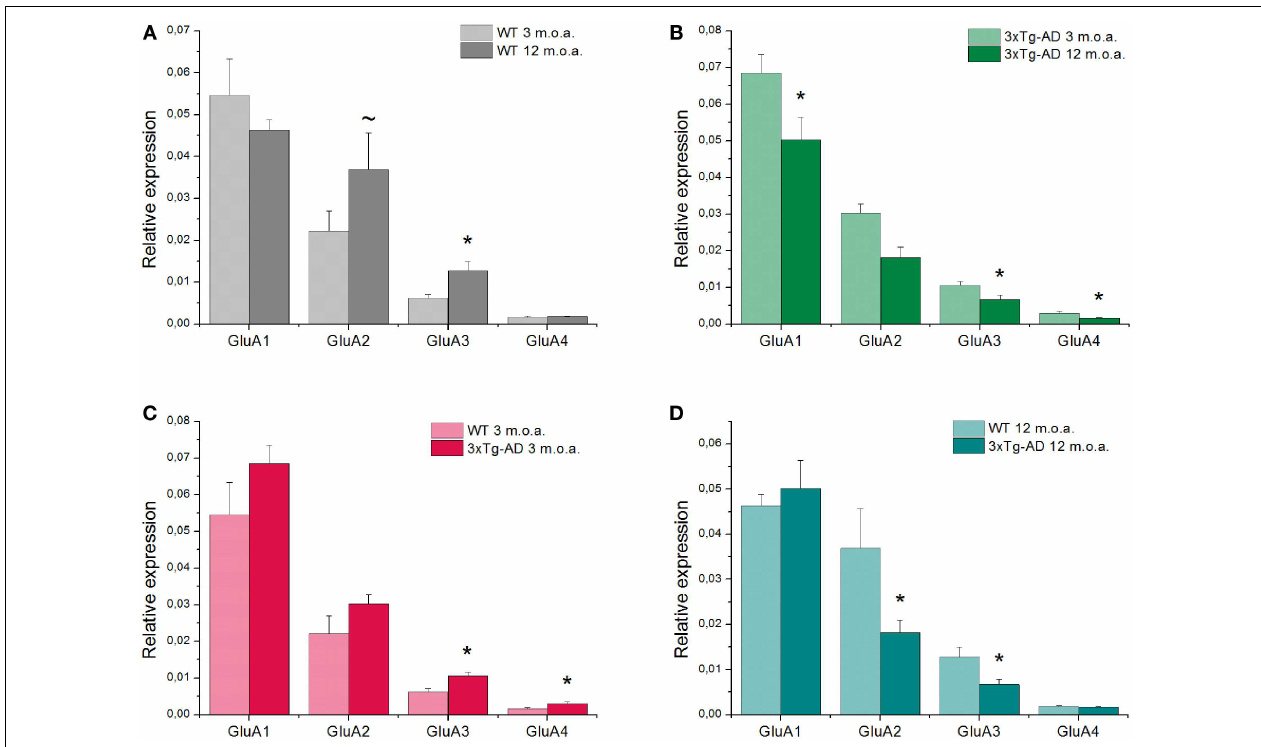
3xTg-AD mice vs.WT mice at 3 m.o.a. showed increases in GluA3 (* p = 0.039) and GluA4 (* p = 0.030) expression levels. (D) Comparison between 3xTg-AD mice vs. age-matchedWT mice showed a decrease in GluA2 (* p = 0.038) and GluA3 (* p = 0.005) expression levels in the 3xTg-AD animals. Data are expressed as mean values ± SEM obtained from six mice in each study group. P value is the result of two-factor ANOVA and Fisher’s